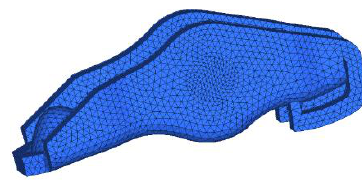
Figure 15. FEM model of the rocker.